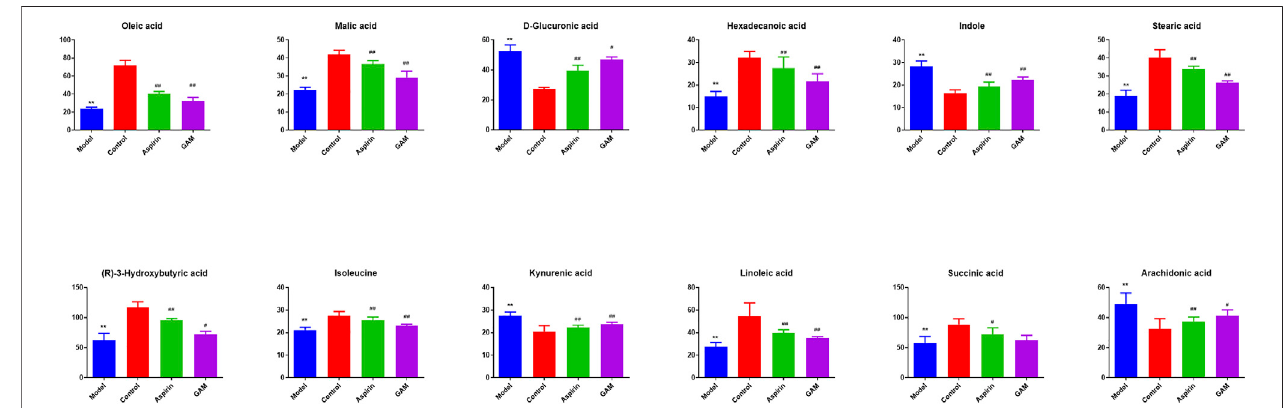
FIGURE 4 | Potential biomarkers in serum with intervening of gallic acid and aspirin. The ordinate represents the numerical values of the metabolite biomarker with normalized peak areas (** p < 0.01 compared with the control; ## p < 0.01, and # p < 0.05 compared with the model group).